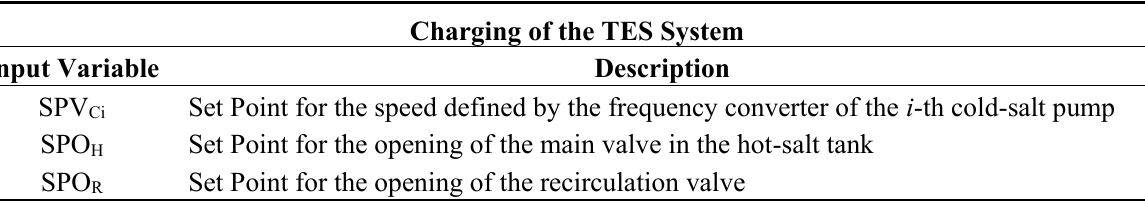
Table 3. TES charging input variables.